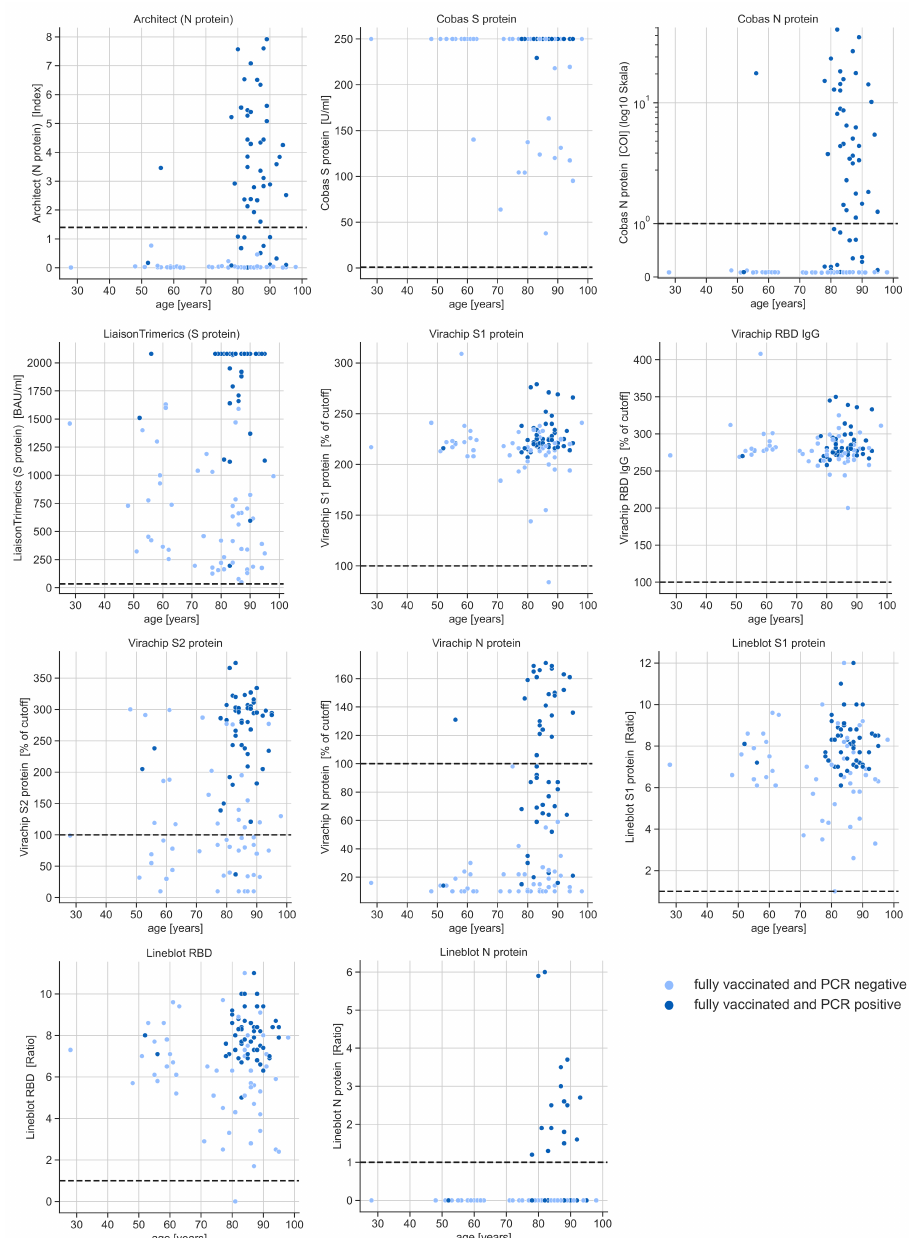
Figure A2. Relationship between measurement values for each assay with age. Dashed line represents cut-off value. Corresponding Spearman Rank correlation coefficients are summarized in Table